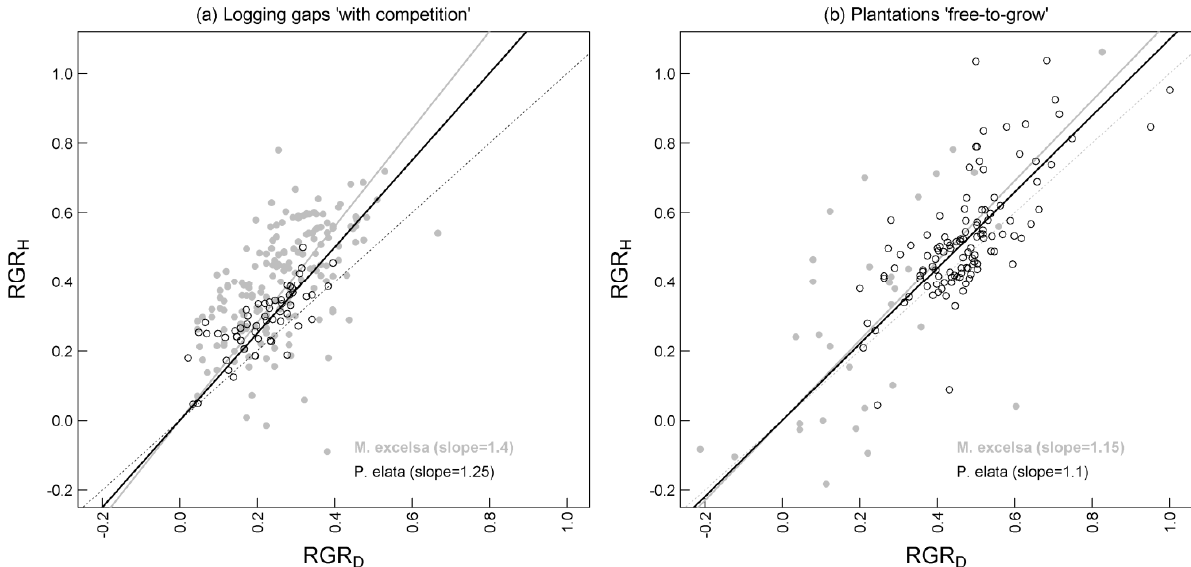
Figure 3. Variations in seedling architecture between M. excelsa (grey dots) and P. elata (black open circles) when grown in logging gaps ( a ) and in plantations ( b ). Seedlings relative growth rate in height ( RGR H , in cm·cm − 1 ·yr − 1 ) was regressed against that in diameter ( RGR D , in mm·mm − 1 ·yr − 1 ) between species and silvicultural experiments. The RGR ratio is equivalent to the scaling coefficient of the power allometric relationship between seedling height and diameter [35]. The dashed grey line corresponds to the 1:1